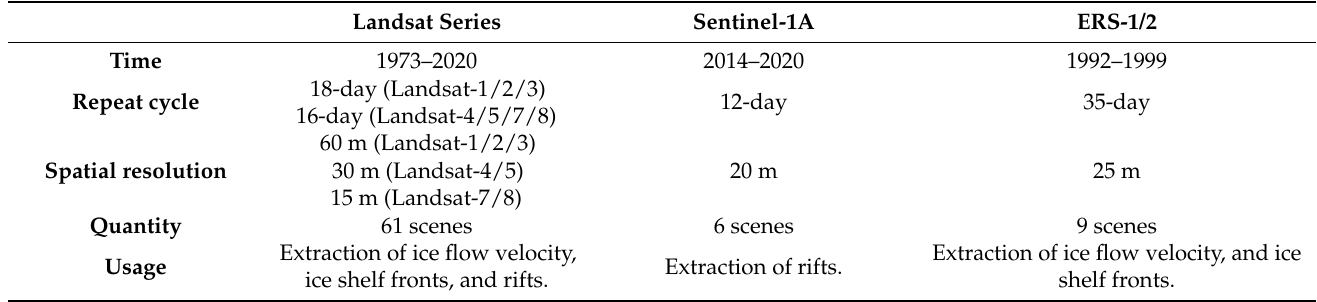
Table 1. Summary of the datasets used in this